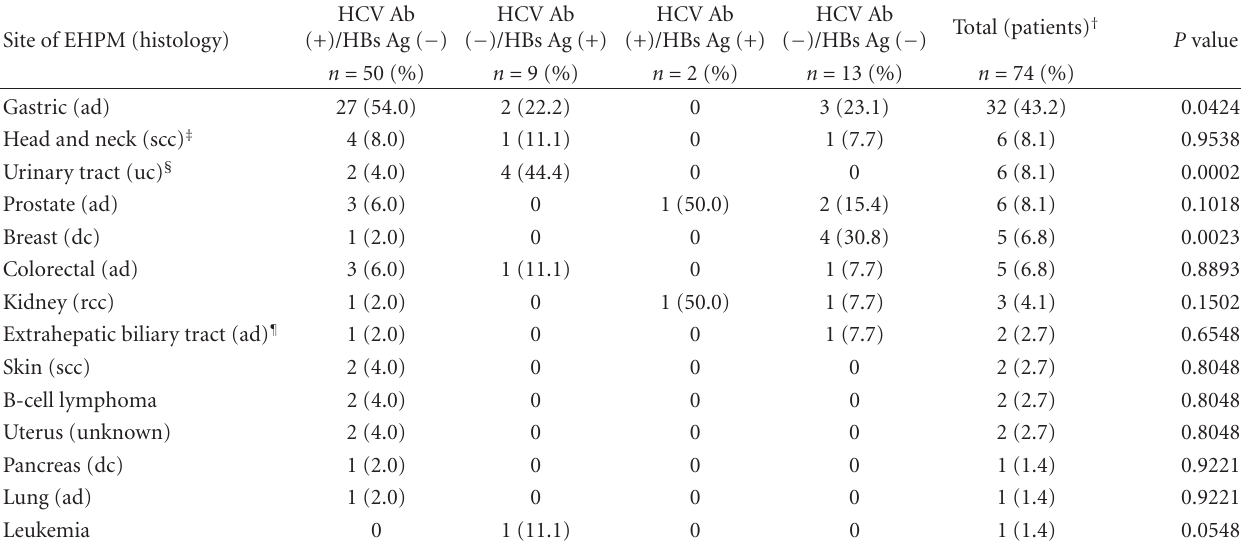
Table 3: Site of EHPM and viral infection status.